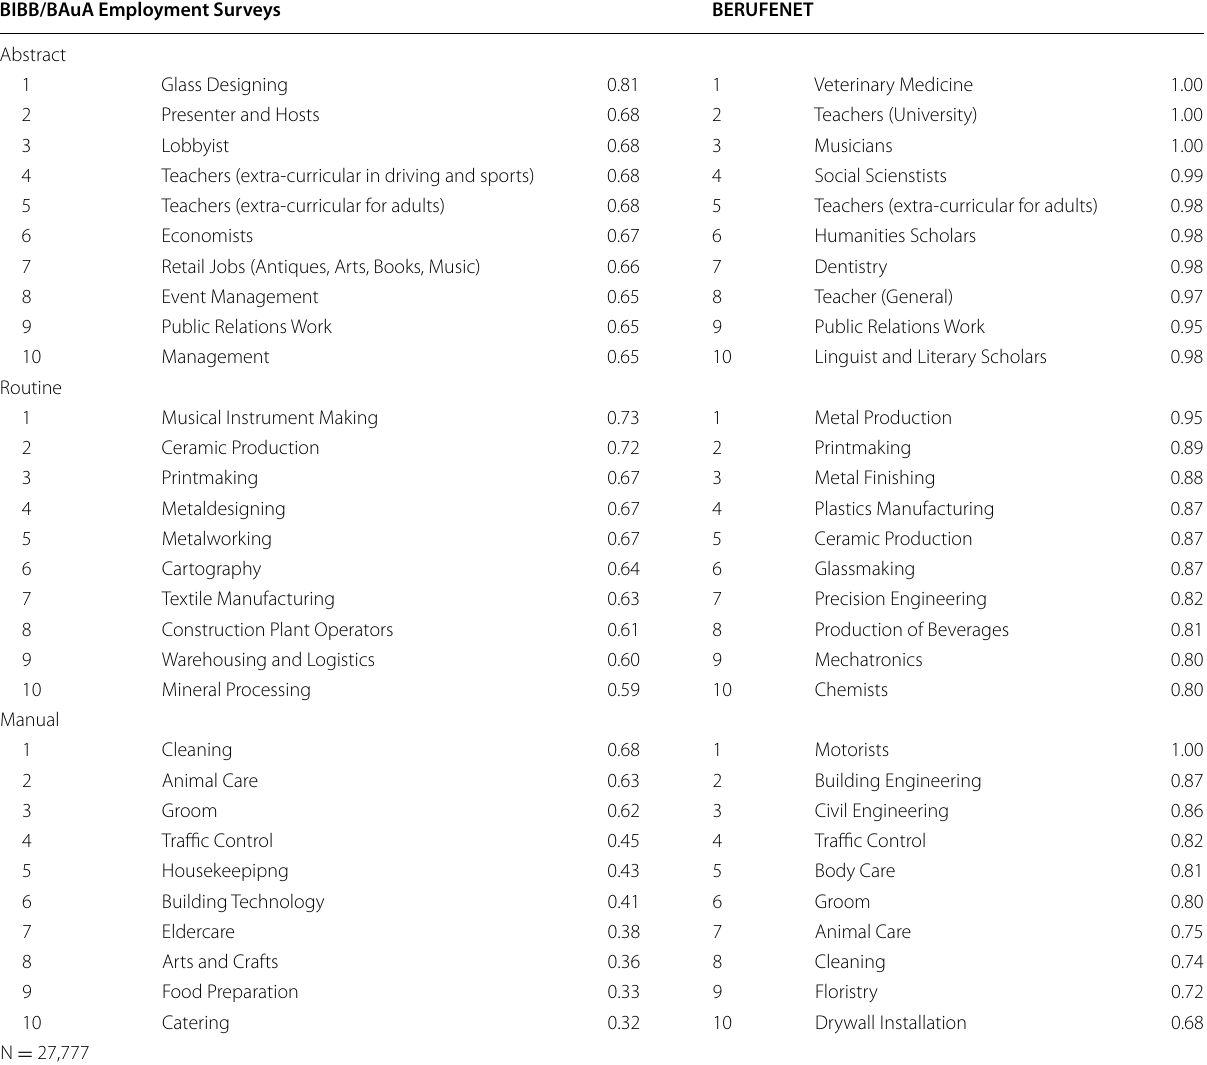
Table 4 Top 10 occupations in abstract, routine, and manual task Intensity: survey vs expert